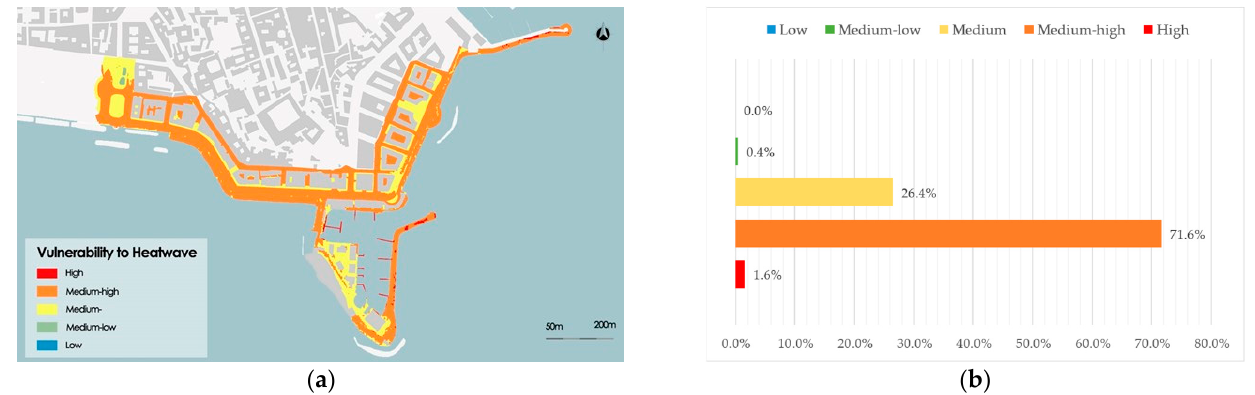
Figure 9. ( a ) Vulnerability to heatwave phenomenon; ( b ) vulnerability histogram of the areas.